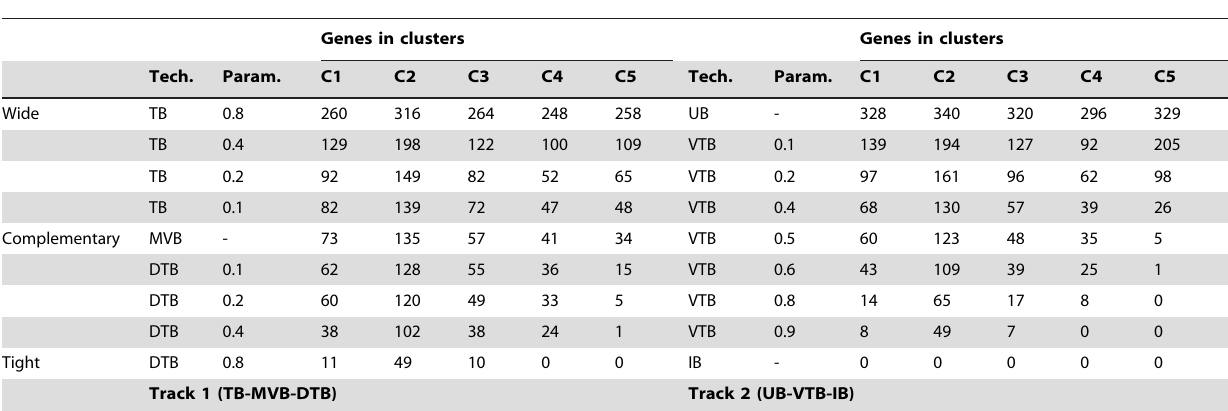
Table 3. Assignment of genes from five real yeast datasets by Bi-CoPaM.